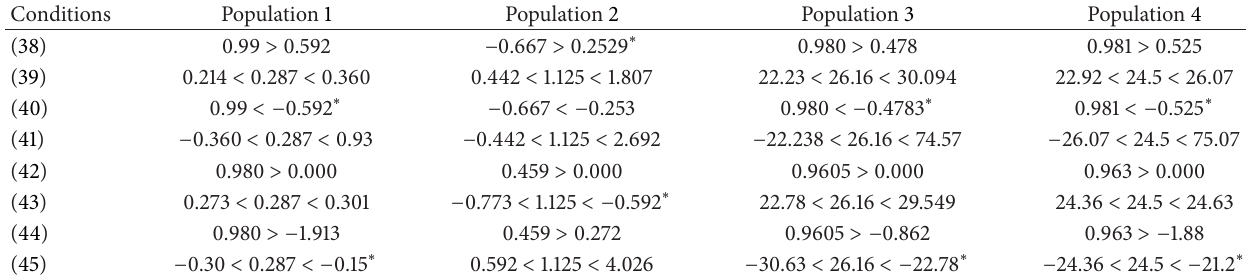
Table 1: Numerical values of conditions (38)–(45).